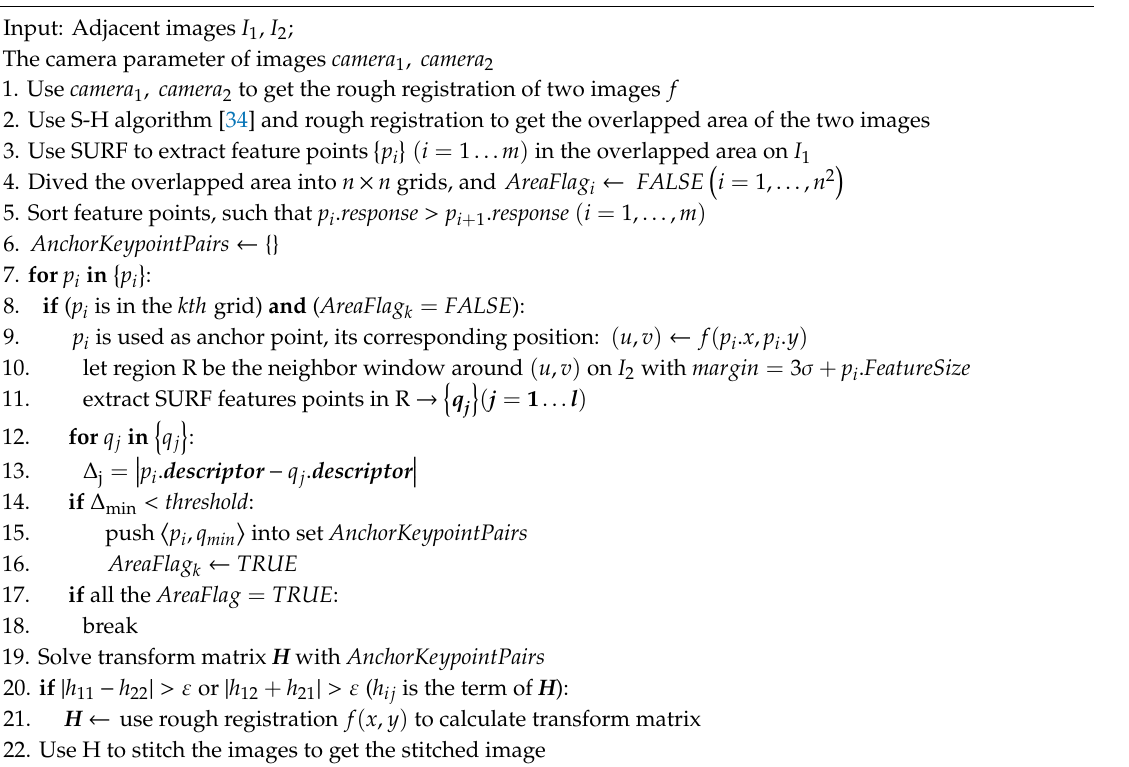
Algorithm 1: The Pseudo-Code of Stitching Two Adjacent